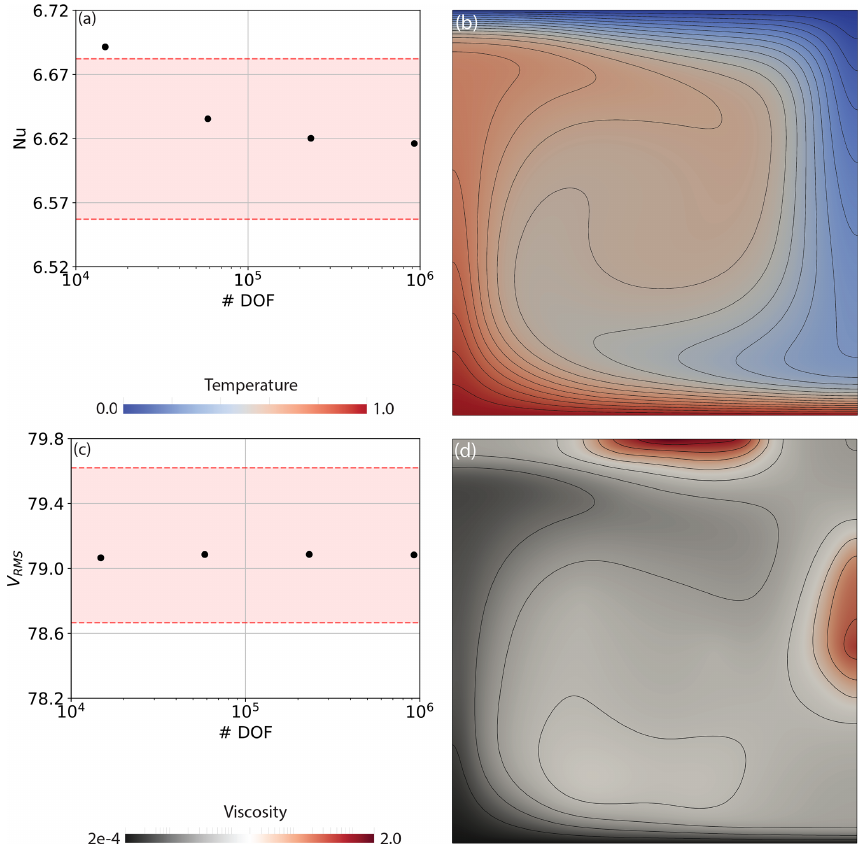
Figure 4. Results from the 2-D benchmark case from Tosi et al. (2015), with a viscoplastic rheology at Ra 0 = 10 2 : (a) Nusselt number vs. number of pressure and velocity DOFs for a series of uniform, structured meshes; (b) final steady-state temperature field, with contours spanning temperatures of 0 to 1, at 0.05 intervals; (c) rms velocity vs. number of pressure and velocity DOFs; (d) final steady-state viscosity field (note logarithmic scale). In panels (a) and (c) , the range of solutions provided by different codes in the Tosi et al. (2015) benchmark study is bounded by dashed red